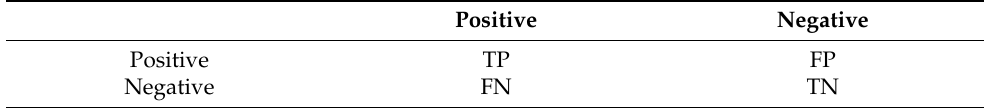
Table 5. The Confusion